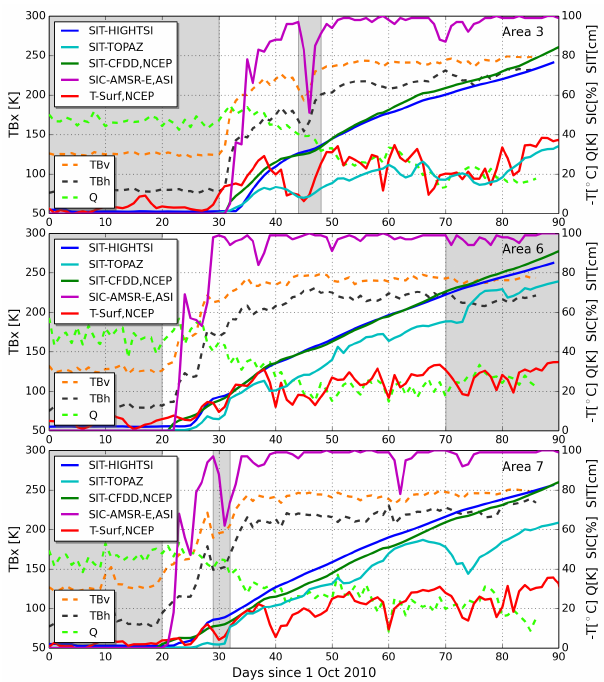
Fig. 4. SIT of training areas 3, 6 and 7 (for location see Fig. 3) from TOPAZ, HIGHTSI and NCEP, air temperature from NCEP, SIC from ASI (AMSRE) and SMOS brightness temperatures. Left Y axis for T B and T B , right Y axis for Q , all SITs, SIC and tem- v h perature; shaded areas are excluded for retrieval